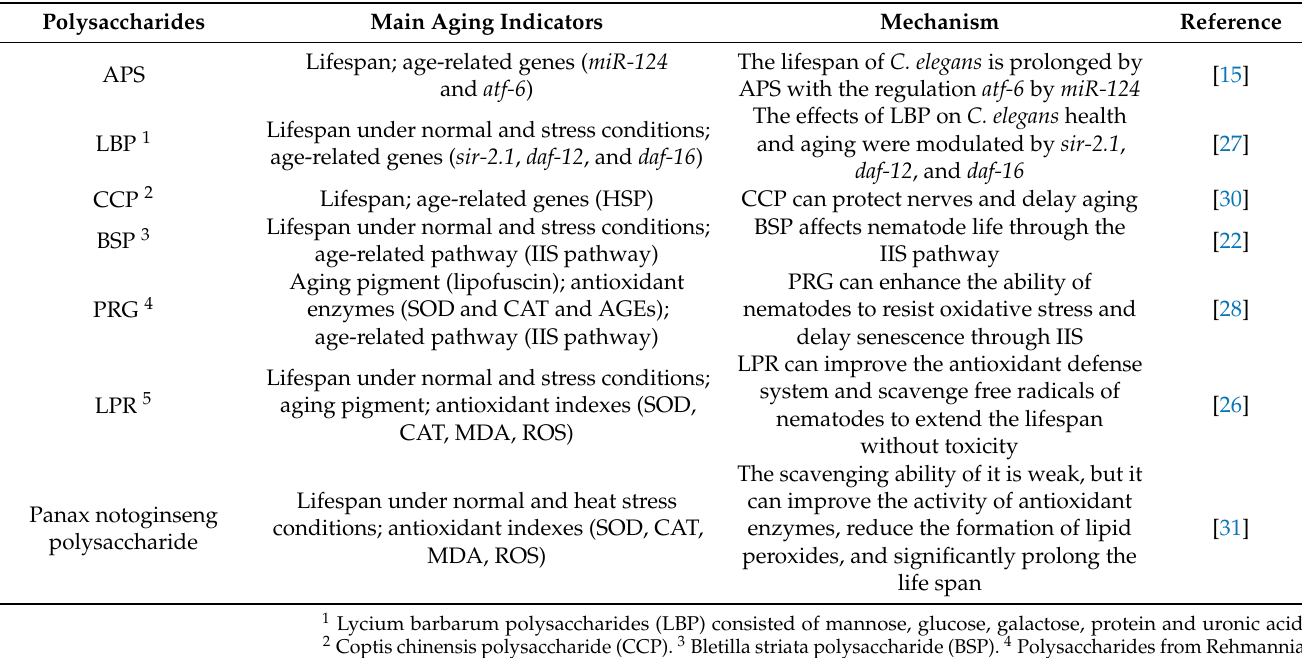
Table 1. Anti-aging study of polysaccharides using C. elegans as a model.